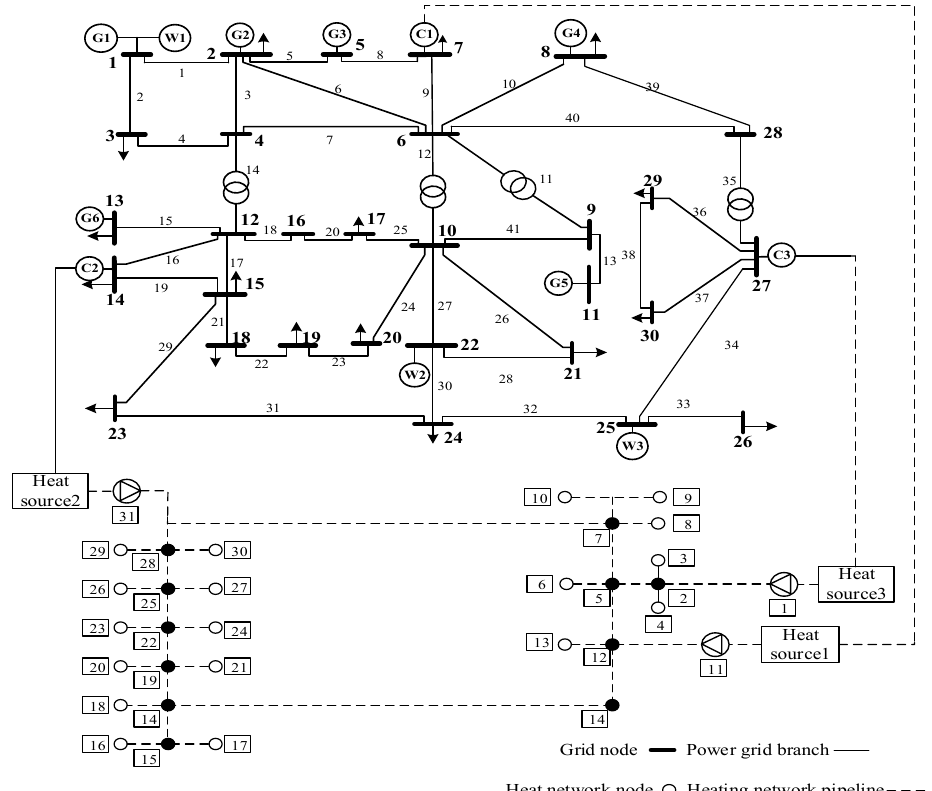
Figure 5. Topology diagram of the integrated energy system. The total power load is shown in Figure 6.